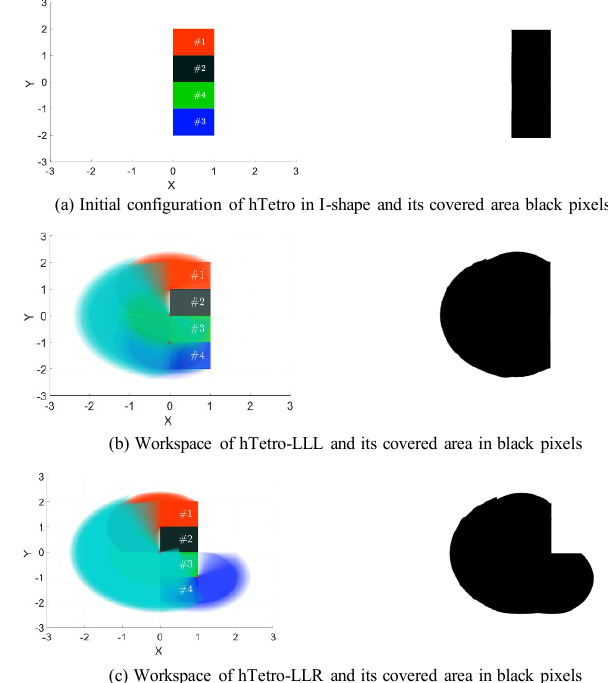
Figure 5. The workspace comparison of the two dissections.